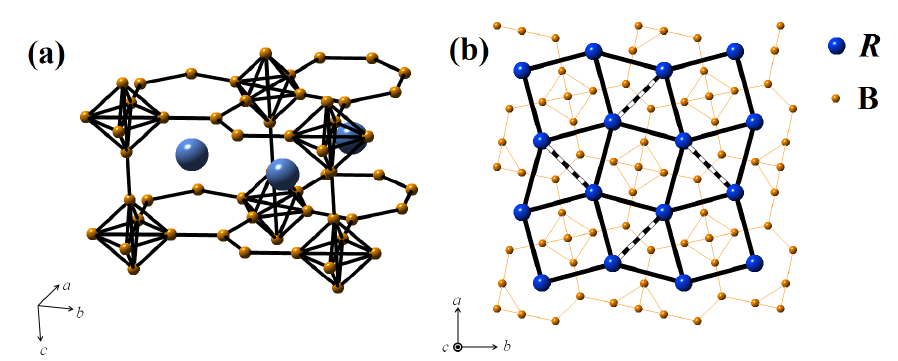
Figure 1. ( a ) Section of R B 4 lattice to illustrate the B 6 octahedra forming chains, as well as the rings above and below the R 3 + ions. ( b ) ab plane of R B 4 to illustrate how the SSL maps to the network of squares and triangles formed by the R 3 +